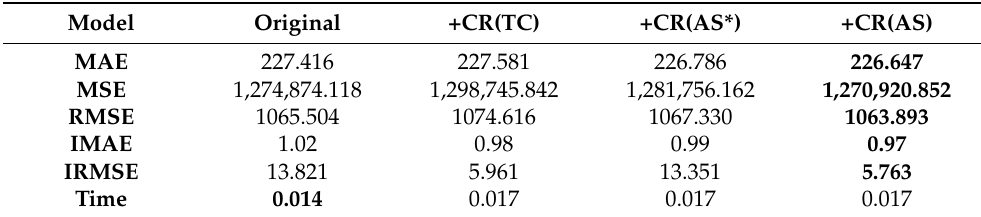
Table 3. The ablation experiments of the confidence re-aggregation module. The bold numbers are the best.